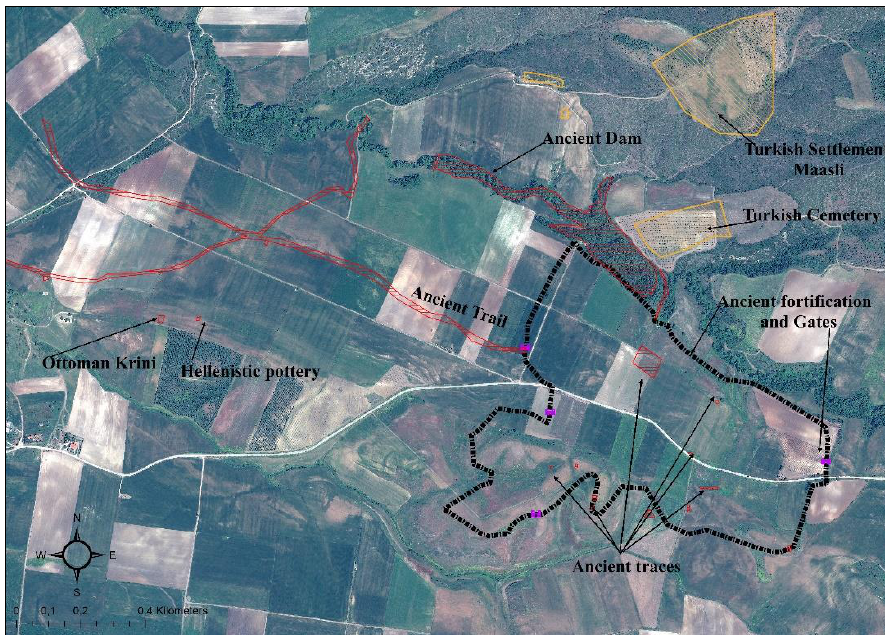
Figure 5. Recording of information collected from residents.